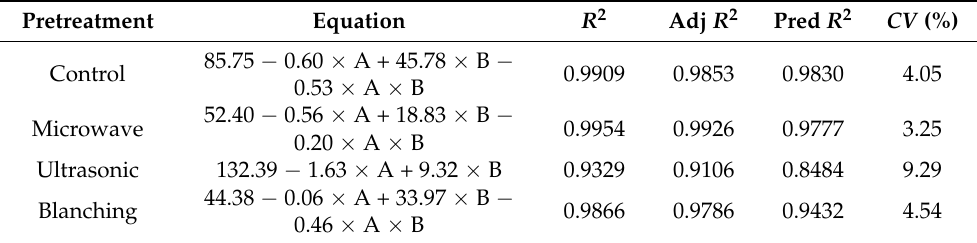
Table 4. Modeling results by the use of RSM for prediction of specific energy consumption ( SEC ) under an HCIR dryer with various